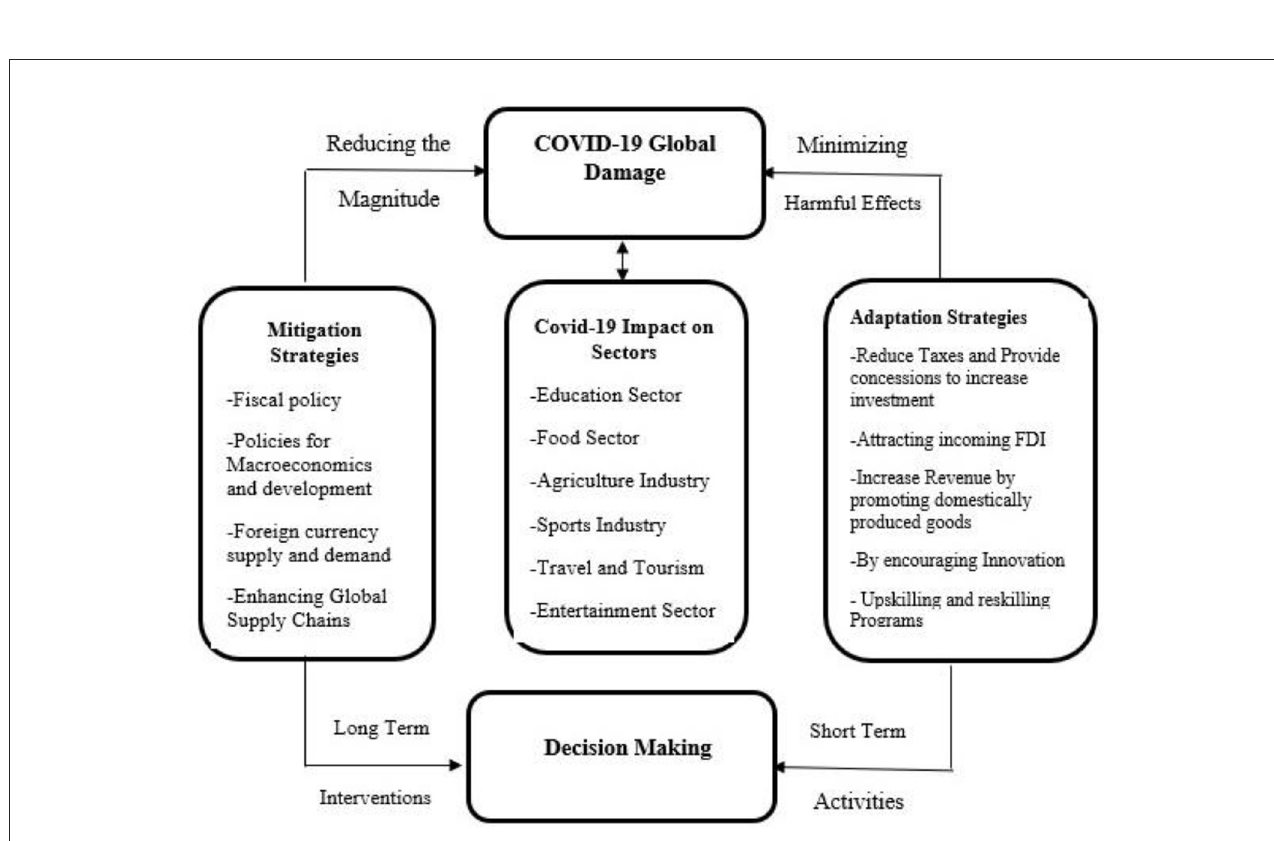
FIGURE14 Sectorial impacts of climate change with adaptation and mitigation measures. Source: Author’s